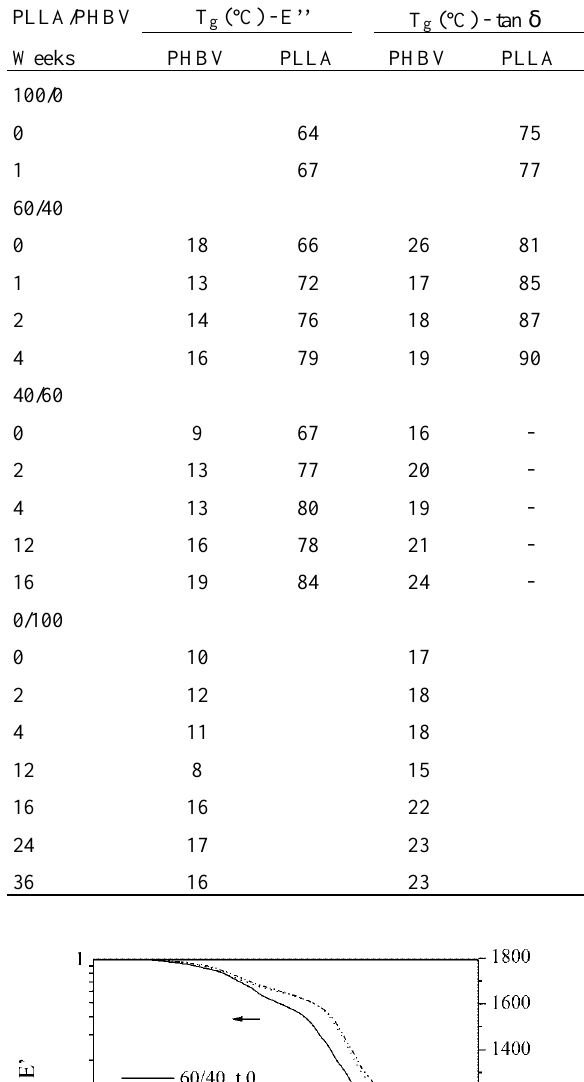
Table 6. Glass Transition Temperatures (T g ) obtained by DMA, on the curves of Loss Modulus (E’’) and damping (tan δ ), for the blends in different compositions and degradation period